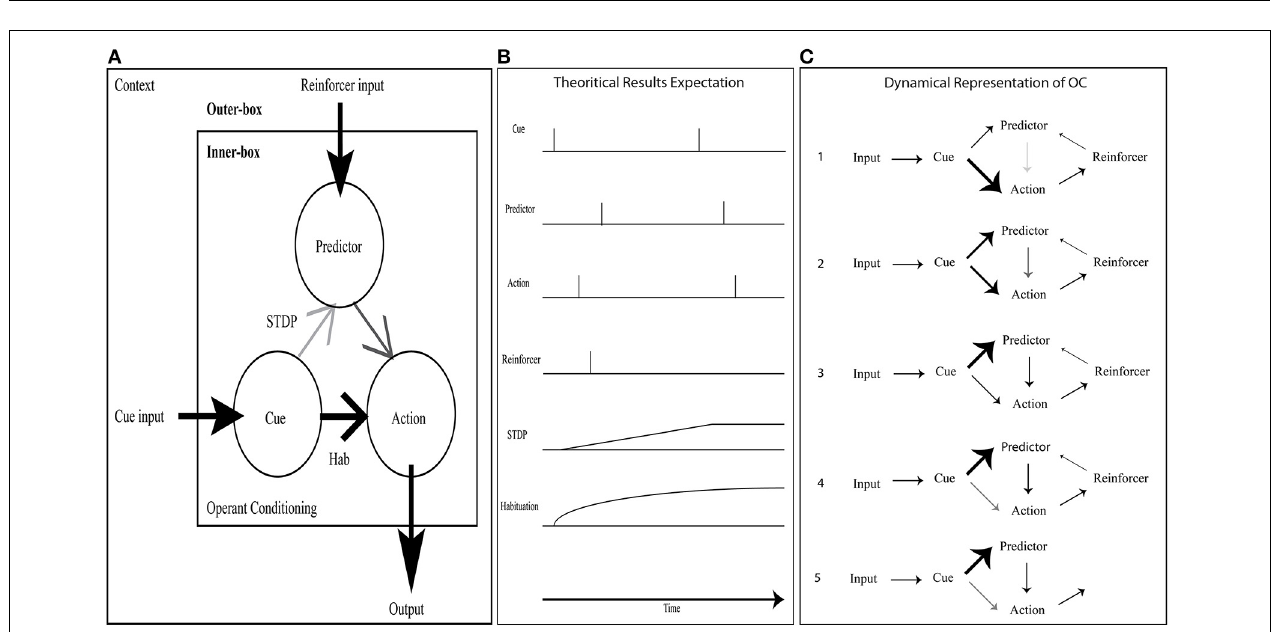
FIGURE 3 | OC simulation with a minimal neural component set. (A) The inner-box consists of a Cue neuron feeding an Action neuron with a strong synaptic link (bold) and a Predictor neuron with a weak link (pale); the link between Predictor and Action is of intermediary strength. A habituation rule between Cue and Action allows decreasing the associated synaptic weight with time, leading to fade the Action. When a reinforcer input triggers a spike from Predictor, consecutively to a spike from Cue, the associated synaptic link